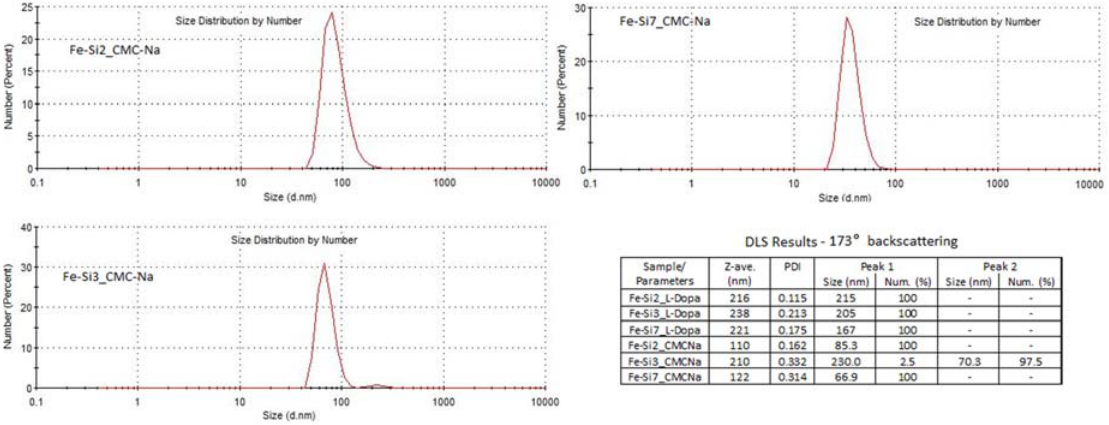
Figure 4. DLS size distribution diagrams of aqueous suspensions containing Fe-Si nanopowders stabilized with CMC-Na and inserted tabulated values of mean hydrodynamic sizes of water- suspended Fe-Si nanoparticle aggregates stabilized with CMC-Na and with L -DOPA.